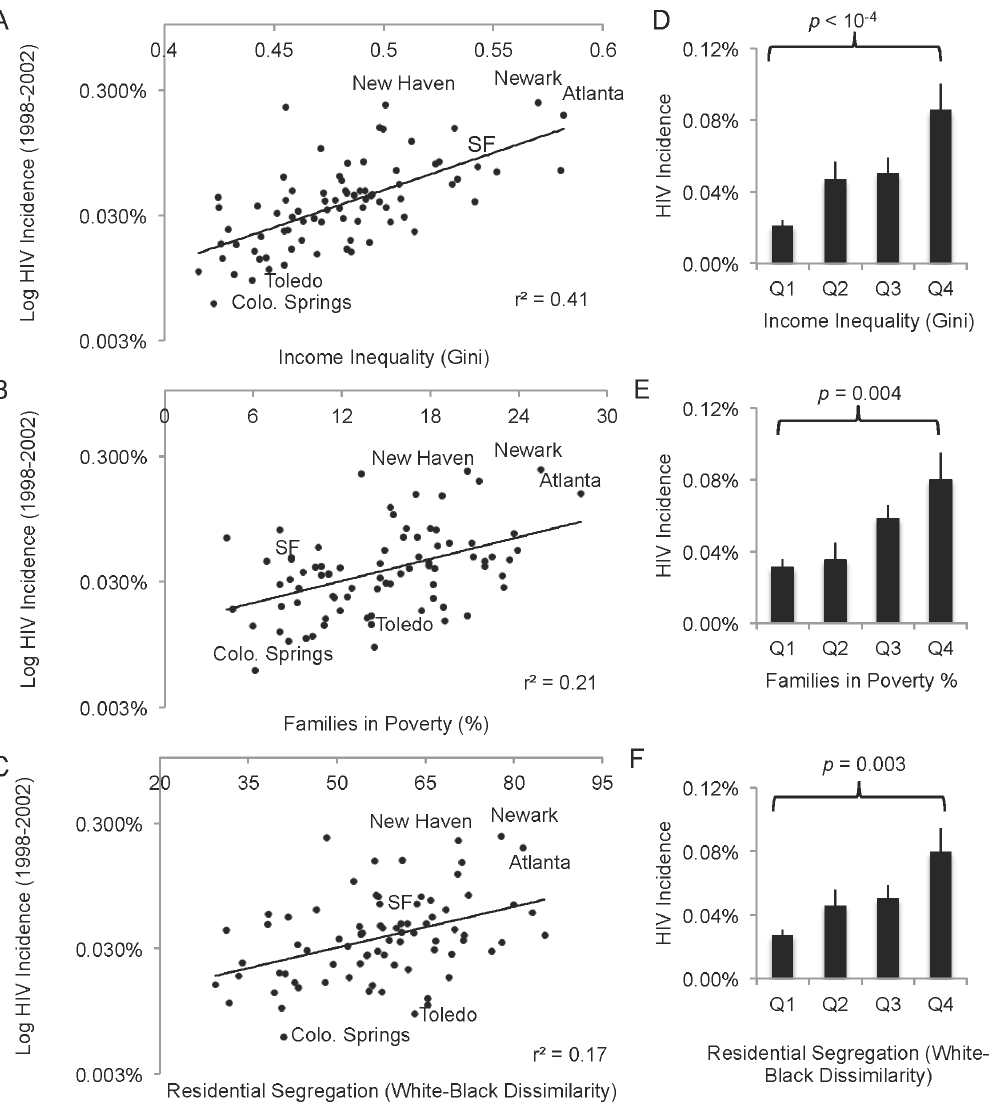
Figure 1. Income inequality, segregation and poverty positively and synergistically correlate with 1998-2002 HIV incidence across 80 U.S. cities. A–C. The total reported HIV incidence in 80 large U.S. cities as a function of: (A) income inequality (represented as the Gini coefficient, where higher values correspond to greater inequality); (B) poverty, and (C) black-white dissimilarity index, a measure of black-white segregation where 0 is completely integrated and 100 completely segregated; and. Cities high in all three social determinants tend to be significantly higher in HIV incidence and vice versa (SF=San Francisco). D–F. Cities were sorted by (D) income inequality, (E) poverty or (F) black-white segregation, and the HIV incidence averaged over quartiles, where Q1 represents the average HIV incidence for the 20 cities with the highest income inequality and Q4 the average HIV incidence in the 20 cities with the lowest income inequality. T-test comparison of the HIV values in first and fourth quarters illustrates these populations are statistically distinct (see Table 1). Bars=SEM. doi:10.1371/journal.pone.0091711.g001 cities for that metric (Figure 2; Table 1). Differences in HIV incidence rates were statistically determined from a ratio T-test for unequal variances in the two quartile groups [40]. High income inequality, low incomes, high unemployment, high poverty, low home ownership and high cost of living (living wage) all correlated positively with HIV incidence, increasing risk by 2–3-fold (Table 1). Additionally, cities with fewer high school graduates and higher segregation experienced similar rises in HIV (Table 1). Indicators of black segregation correlated (Table 1); Hispanic segregation did not (data not shown). Rates of marriage were even more highly correlated, with low-marriage-rate cities experiencing , 4-fold higher HIV rates.